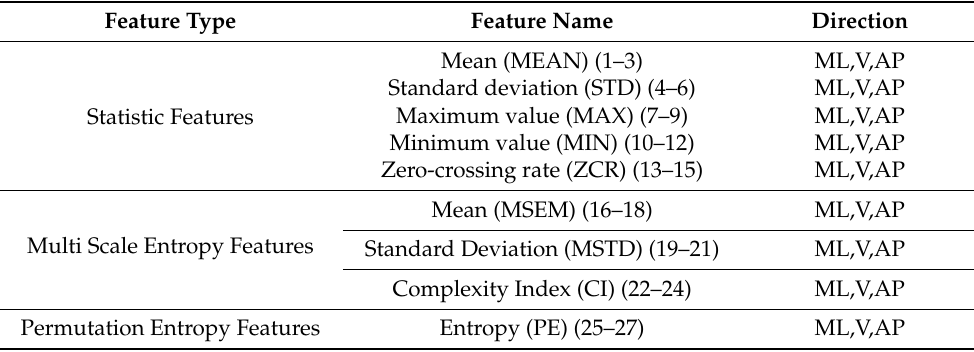
Table 3. List of features extracted from the inertial sensor data.